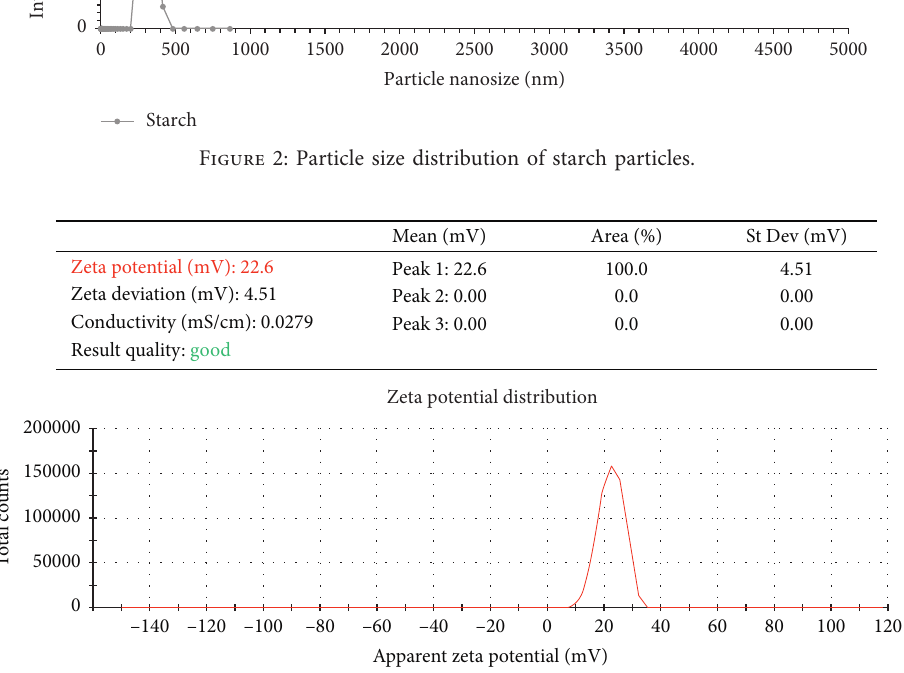
Figure 3: Starch zeta potential